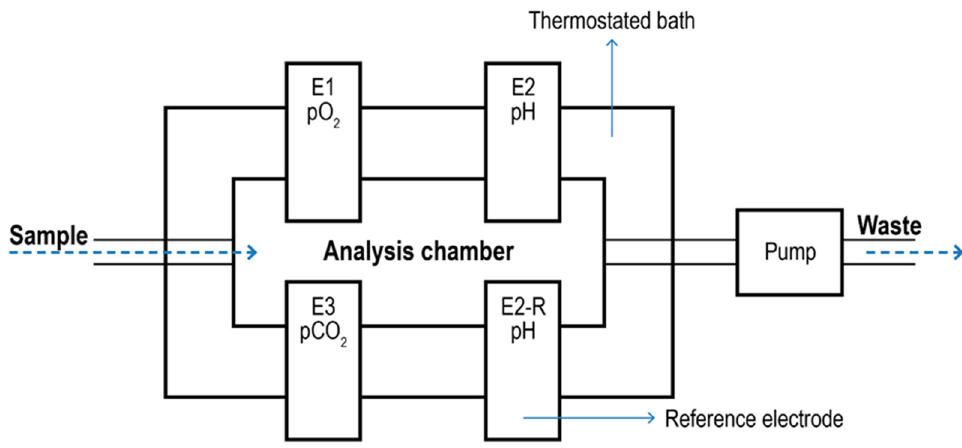
Figure 8. Schematic of a blood gas analyzer system. The sample enters a thermostatic chamber containing the electrodes (E1) due to pump aspiration. E2-R2 represents the pH reference electrode.